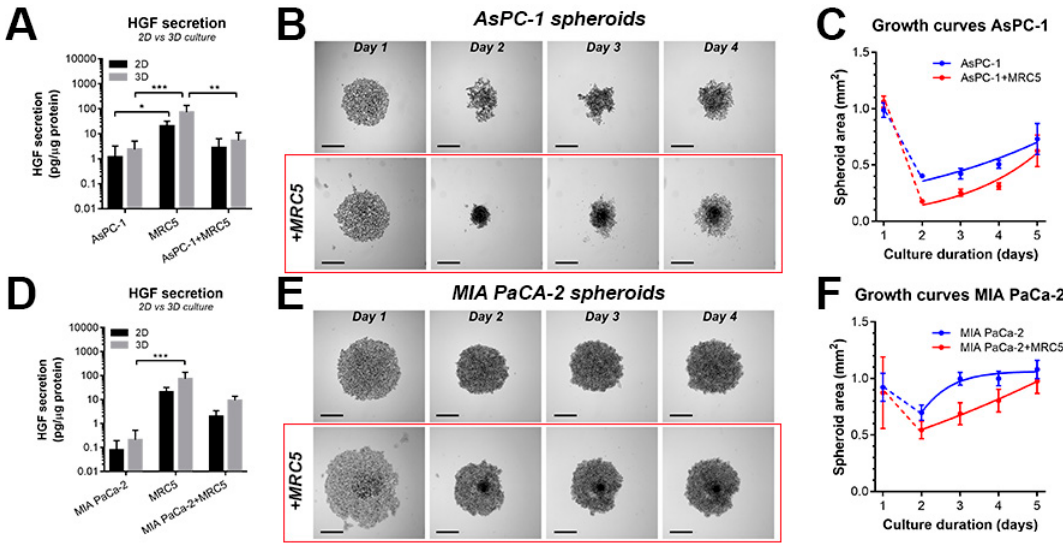
Figure 1. Establishment and characterization of heterotypic pancreatic ductal adenocarcinoma (PDAC) spheroids. ( A ) Quantification of hepatocyte growth factor (HGF) secretion in the conditioned media (48 h) of AsPC-1, MRC5, and AsPC-1+MRC5 2D monolayer (co-) cultures (grey bars) or 3D spheroid (co-)cultures (black bars). Depicted are the mean ± SEM of N = 6–10 from ≥ 3 technical repeats. ( B ) Brightfield images of AsPC-1 and AsPC-1+MRC5 spheroid growth. Scale bar = 250 µm. ( C ) Growth kinetics of AsPC-1 and AsPC-1 + MRC5 spheroids based on quantitative analysis of the brightfield images. Depicted are the mean ± 95% CI of N = 16–32 from 3 technical repeats. ( D ) Quantification of HGF secretion in the conditioned media (48 h) of MIA PaCa-2, MRC5, and MIA PaCa-2 + MRC5 2D monolayer (co-)cultures (grey bars) or 3D spheroid (co-)cultures (black bars). Depicted are the mean ± SEM of N = 4–6 from ≥ 2 technical repeats. ( E ) Brightfield images of MIA PaCa-2 and MIA PaCa-2 + MRC5 spheroid growth. Scale bar = 250 µ m. ( F ) Growth kinetics of MIA PaCa-2 and MIA PaCa-2 + MRC5 spheroids based on quantitative analysis of the brightfield images. Depicted are the mean ± 95% CI of N = 16–48 from ≥ 3 technical repeats. Statistical significance is indicated as * p < 0.05, ** p < 0.01, *** p < 0.005.